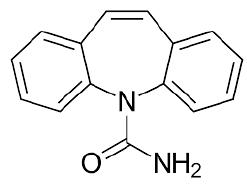
Figure 8. The structure of Carbamazepine.